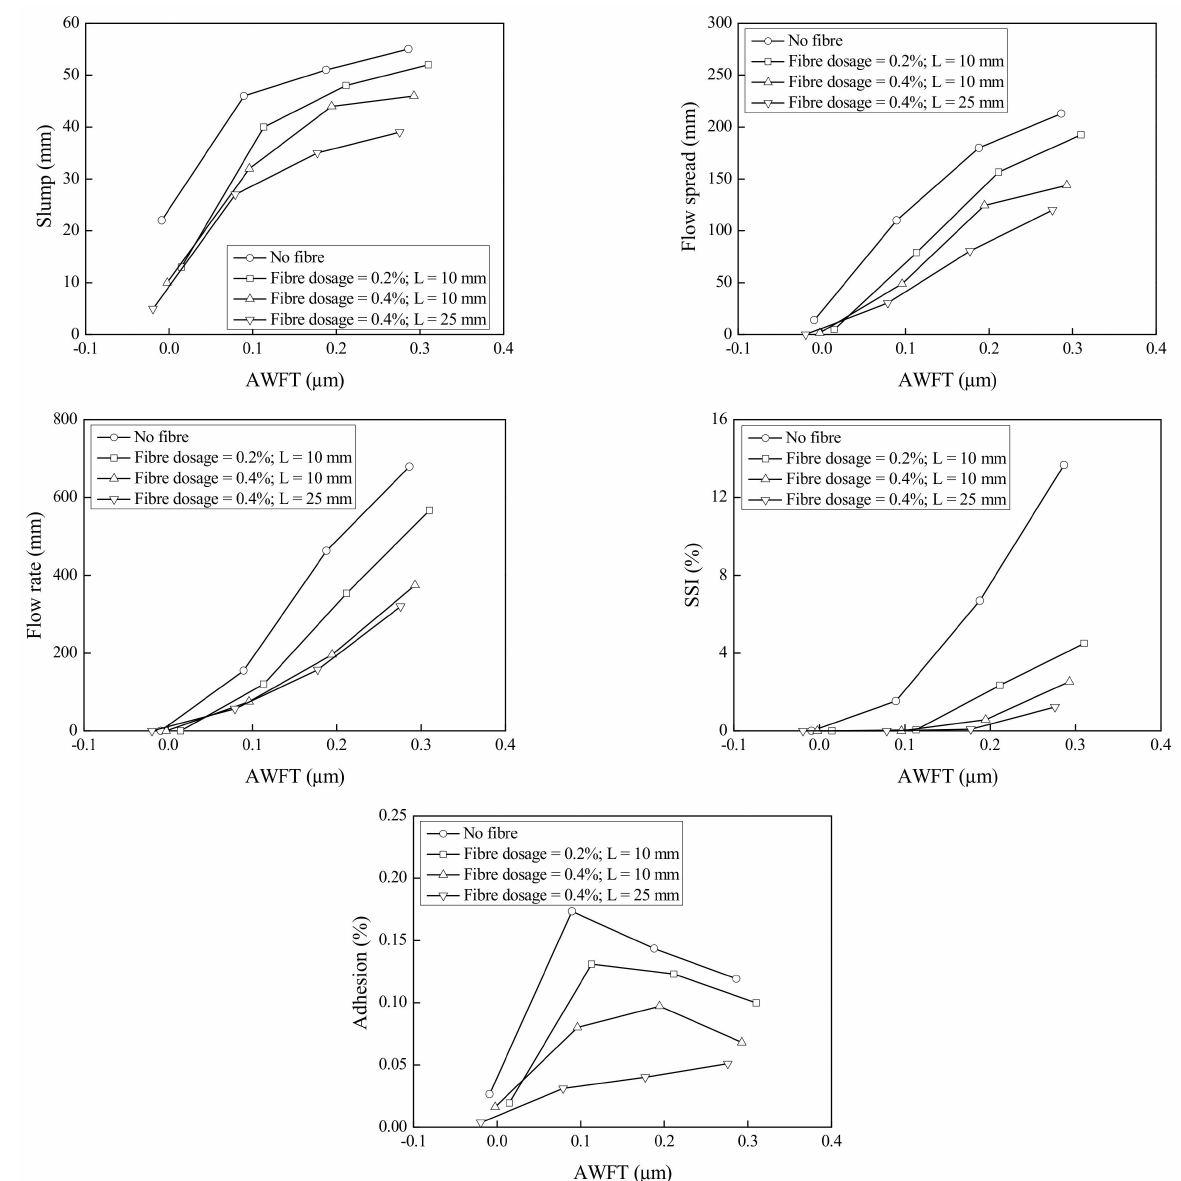
Figure 4. Fresh behaviours of BFRM versus AWFT for different fibre dosages and